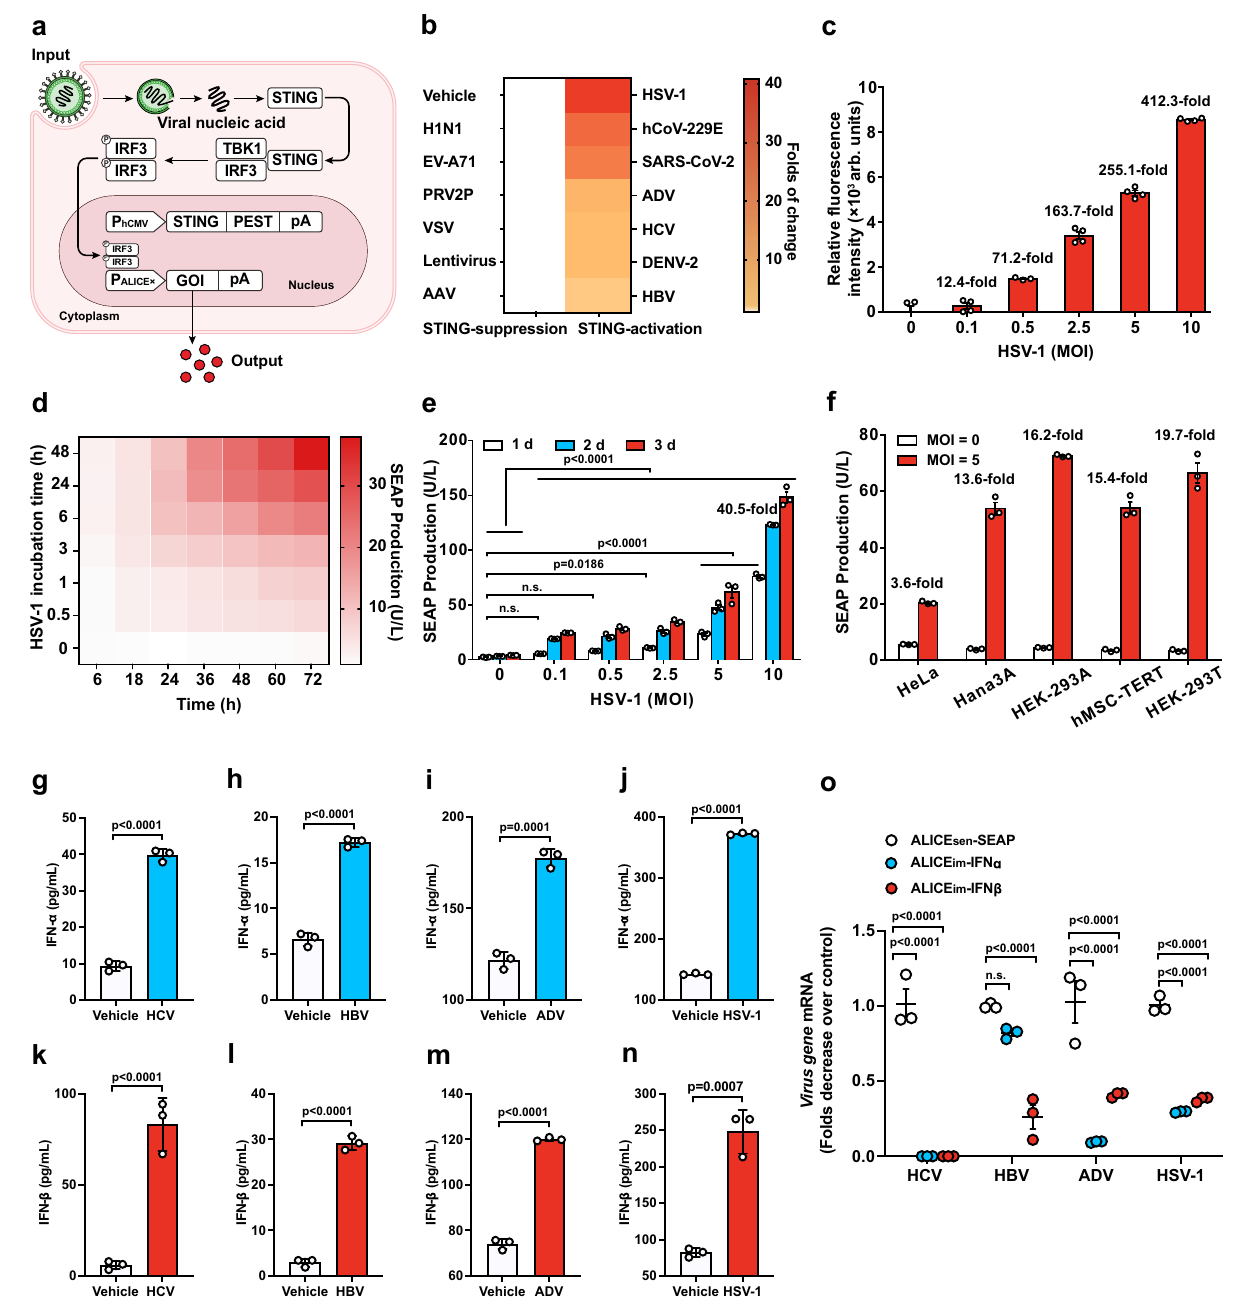
Fig. 1 | Design and characterization of an autonomous, intelligent, virus- inducible immune-like sensor (ALICE sen ). a Schematic illustration of the design principleforavirussensor(ALICE sen ).Virusinfectsmammaliancellsandreleasesits nucleic acid into the cytoplasm, which activates the destabilized STING (pYW274). Activated STING triggers a synthetic immune signaling pathway mediated by endogenous tank-binding kinase 1 (TBK1), resulting in activating phosphorylation and dimerization of endogenous interferon regulatory factor 3 (IRF3), which translocatesintothenucleusasadimerandinitiatestheexpressionofagivengene of interest (GOI) under the control of a “ virus-inducible promotor (P ALICE× ) ” sequence. b Fold change of SEAP in ALICE sen induced by different STING-sup- pression/activation viruses. pYW274/pWS67-transgenic cells were incubated with differentvirusesasindicated,andSEAPinsupernatantwasquanti fi edat2and4dpi (day post-infection). c HSV-1-dependent EGFP expression in ALICE sen . pYW274/ pYW379-transgenic HEK-293T cells were incubated with different titers of HSV-1 (MOI=0 – 10) and quanti fi ed at 2 dpi. d Time-dependent SEAP production kinetics